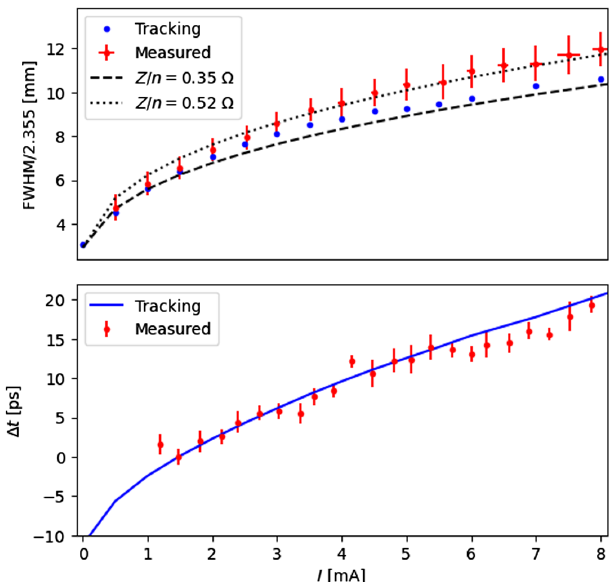
FIG. 8. Top: the measured bunch length versus single bunch current compared with simulations. The dashed lines are sol- utions of Eq. (2) where Im ð Z k =n Þ was fit to the data. Bottom: bunch phase shift versus single bunch current compared to